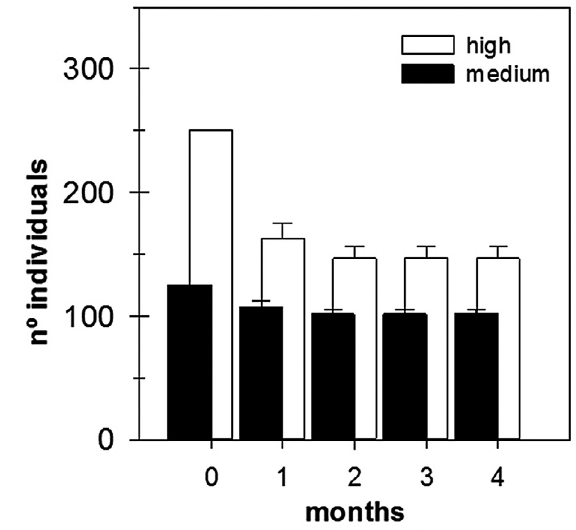
Fig. 6. – Marphysa “sp.” population evolution at high and medium densities for four